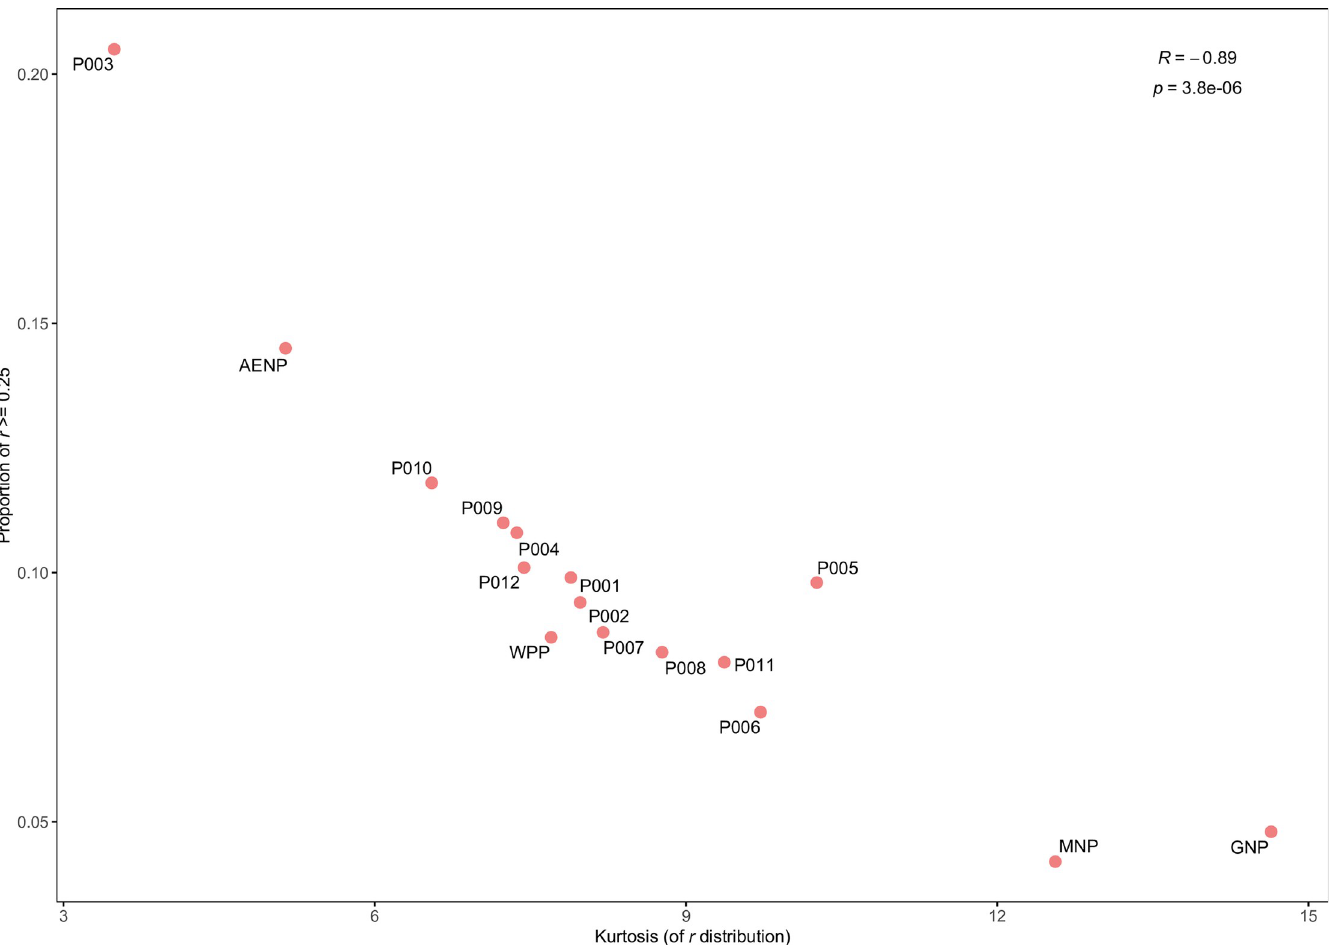
Fig 3. Scatterplot showing the correlation between kurtosis and proportion of relatedness values � 0.25. Pearson’s correlation coefficient ( R ) and the associated p - value are